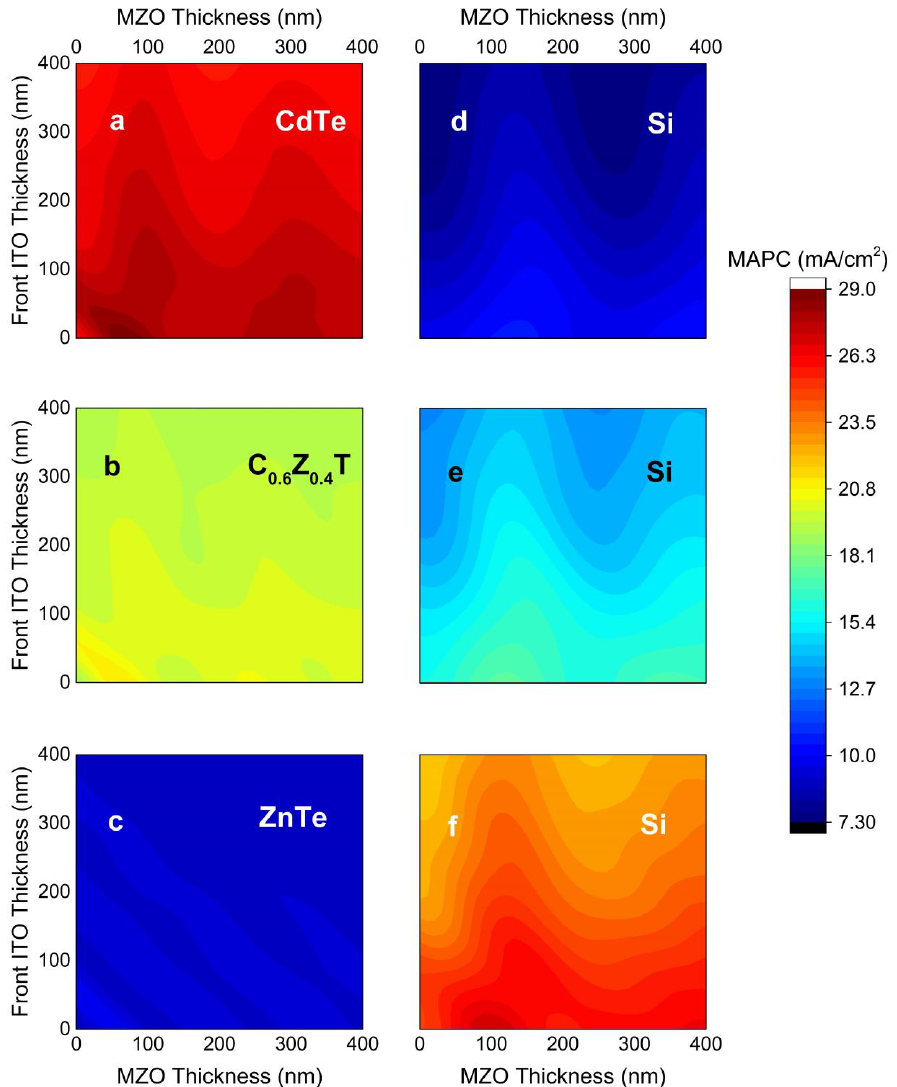
Figure 5 Figure 5. MAPC of CdTe ( a ), C 0.6 Z 0.4 T ( b ), and ZnTe ( c ) top cells, along with the corresponding IBC